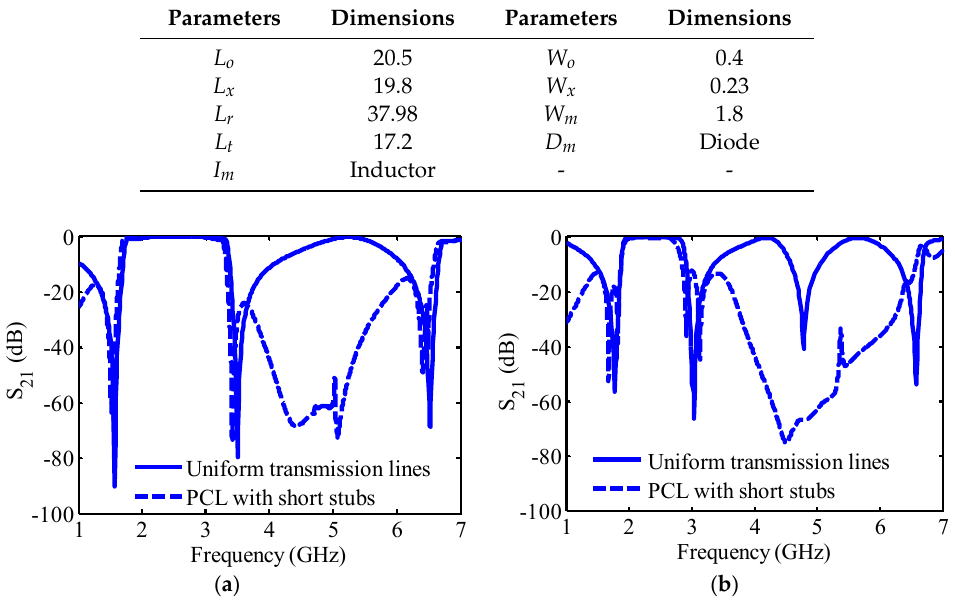
Table 2. Design dimensions for 3 λ g / 4 open-ended stubs (Units: mm). Table 3. Design dimensions for λ g /2 short-ended stubs (Units: mm).